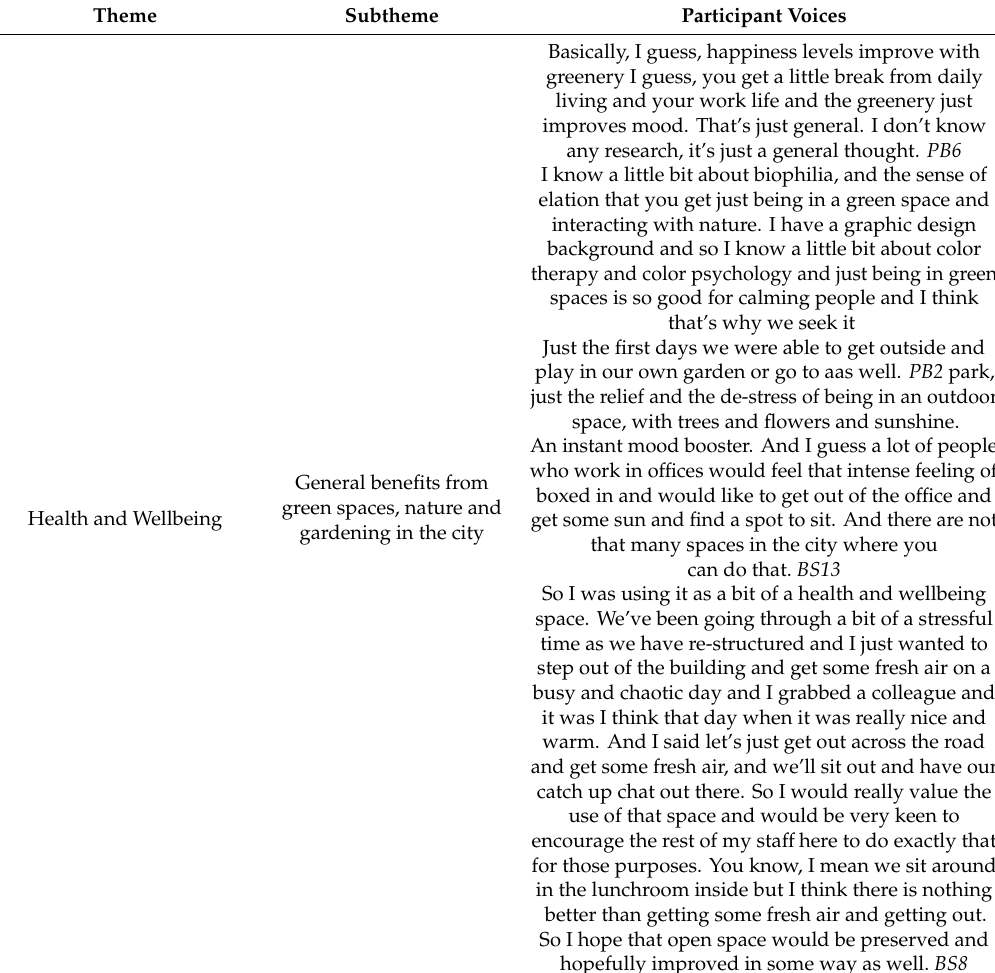
Table A1. Additional qualitative